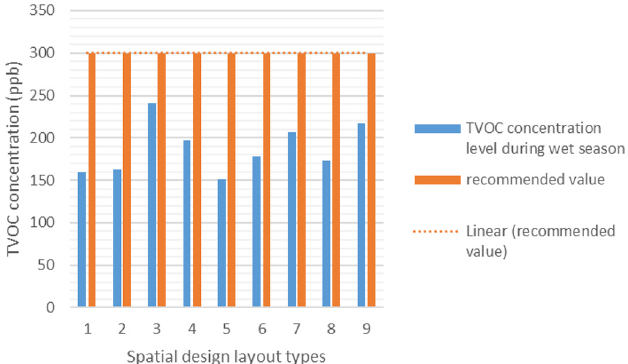
Fig. 9. TVOC concentration levels in the different spatial design layouts during wet season.